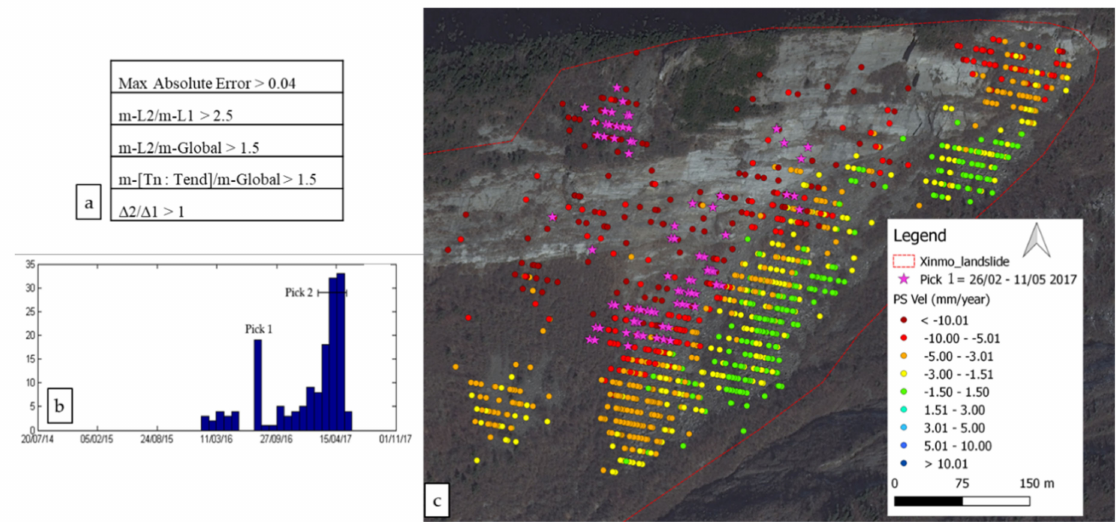
Figure 14. ( a ) Thresholds used as the stopping criteria. ( b ) Temporal distribution of the breakpoints. ( c ) Spatial distribution of the MPs showing a trend change between February 2017 and May 2017 (pink stars).